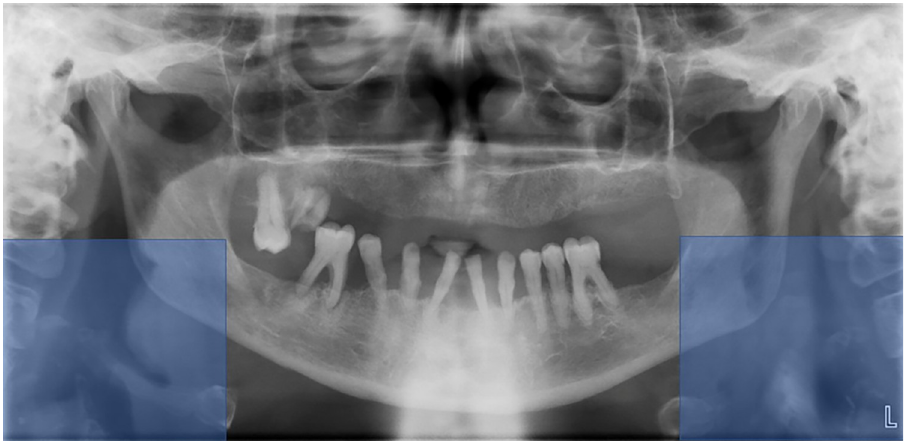
Fig 1. The region of interest is located near the C3-C4 spinals. Therefore, we cut out each of the lower corners of the panoramic image in 500 X 500 pixels size (depicted with light blue rectangles). This size ensured that the corners encompassed the